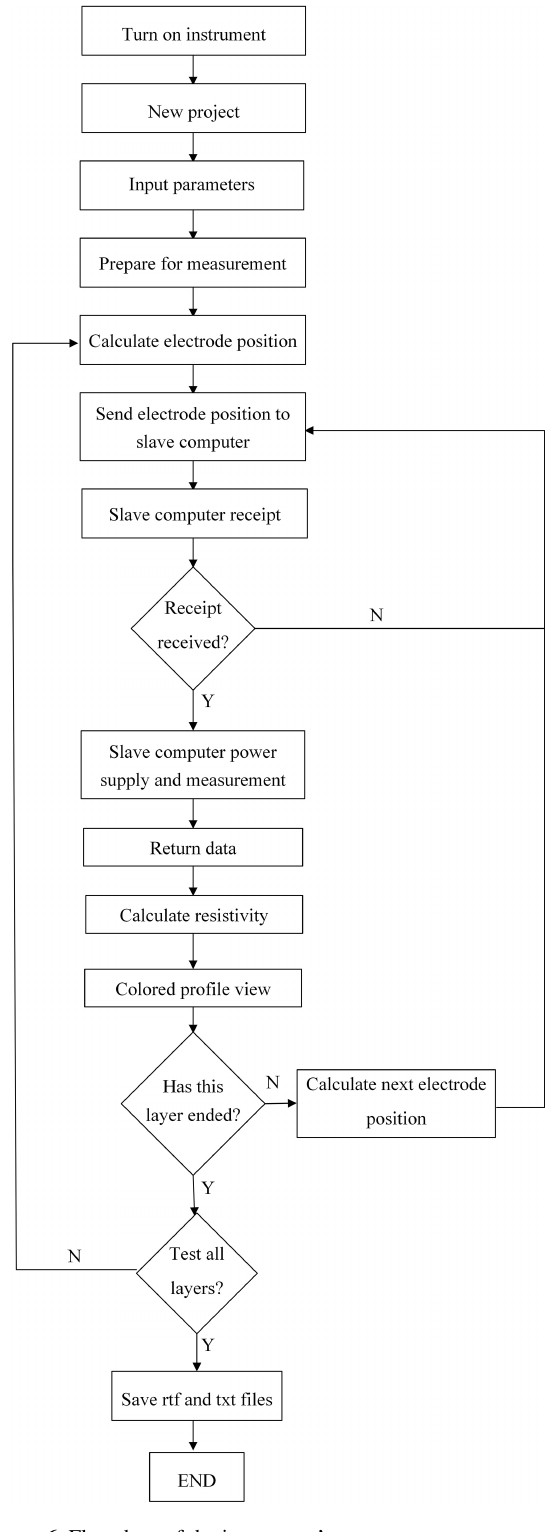
Figure 6. Flowchart of the instrument’s program.